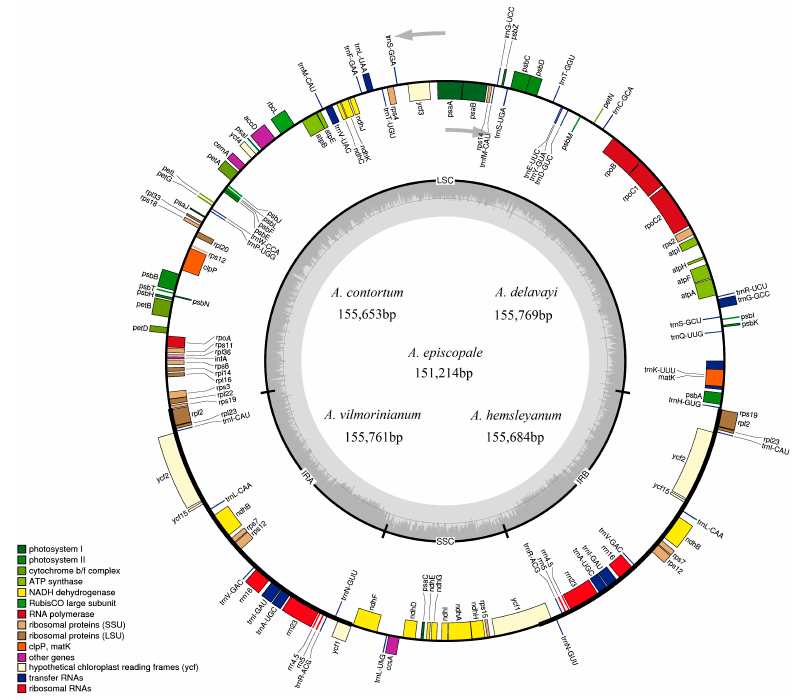
Figure 1. Chloroplast genome map of five Aconitum species. Genes lying outside the circle are transcribed in the counter clockwise direction, while those inside are transcribed in the clockwise direction. The colored bars indicate different functional groups. The darker gray area in the inner circle denotes GC content while the lighter gray corresponds to the AT content of the genome. LSC: large single copy, SSC: Small single copy, IR: inverted repeat.